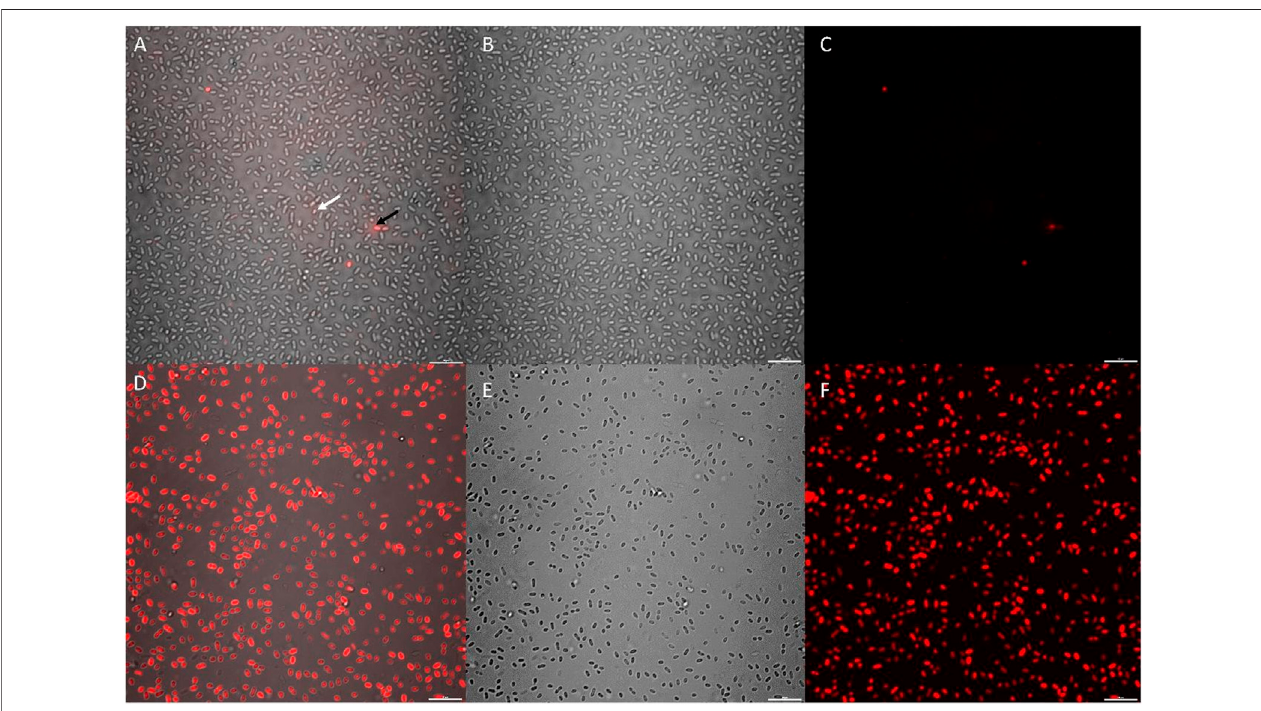
FIGURE 6 | CLSM micrographs depicting K. pneumoniae cells stained with a 10 x concentration of Cellbrite Fix 555; where (A – C) (cid:1) untreated control sample and (D – F) (cid:1) CTA-4OHcinn treated sample. (A,D) compare combined channels, (B,E) compare transmission detector channels and (C,F) compare fl uorescent signal only. The white arrow indicates a live cell with low Cellbrite Fix 555 signal (membrane fl uorescence) and the black arrow indicates a membrane compromised cell emitting greater